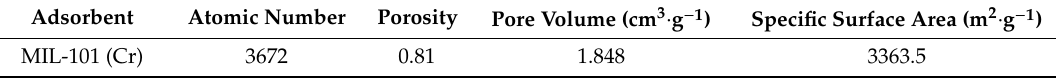
Figure 1. Structures of the MIL-101 (Cr) crystal and cluster. Table 2. The unit cell characteristic parameters of MIL-101 (Cr). Table 2. The unit cell characteristic parameters of MIL-101 (Cr).